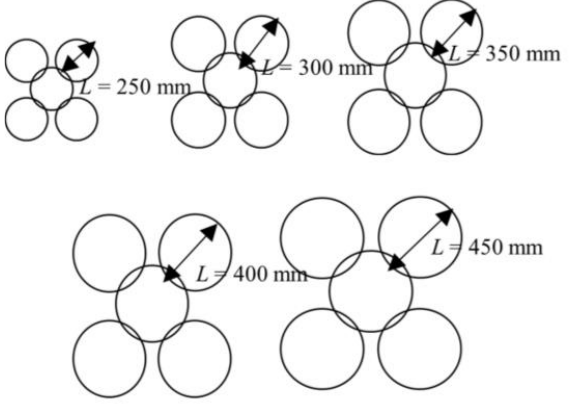
Figure 16. Ring net model with different ring diameters.